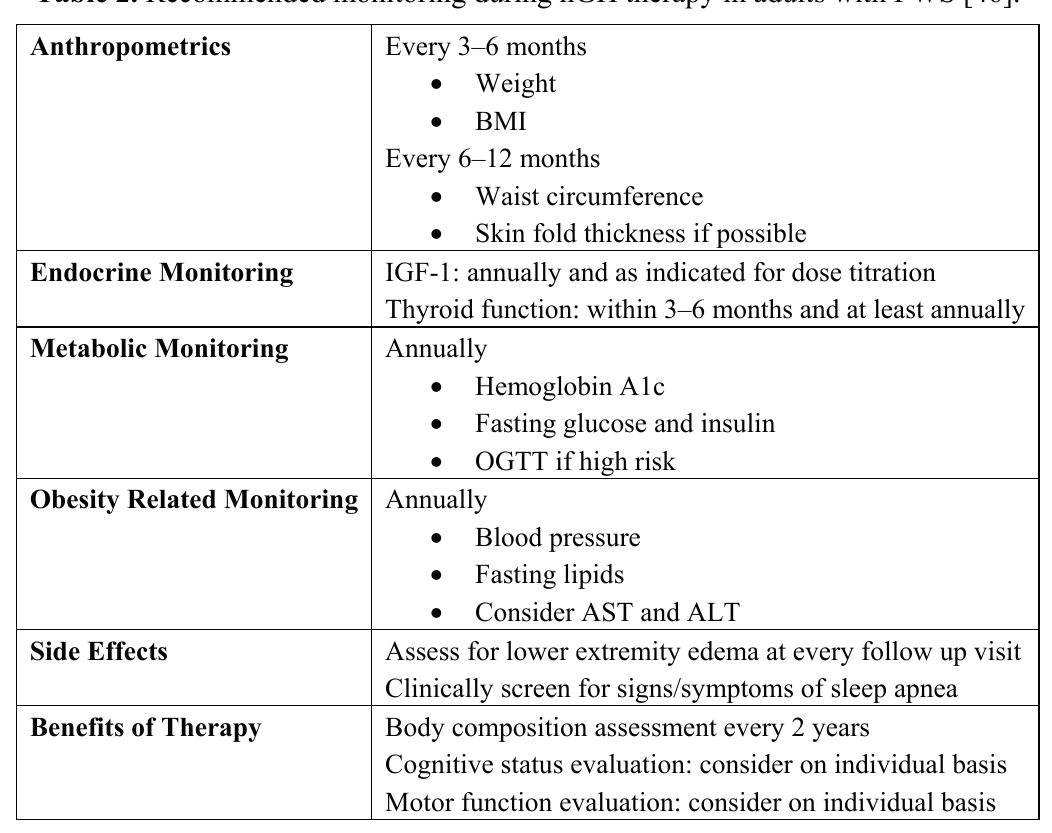
Table 2. Recommended monitoring during hGH therapy in adults with PWS